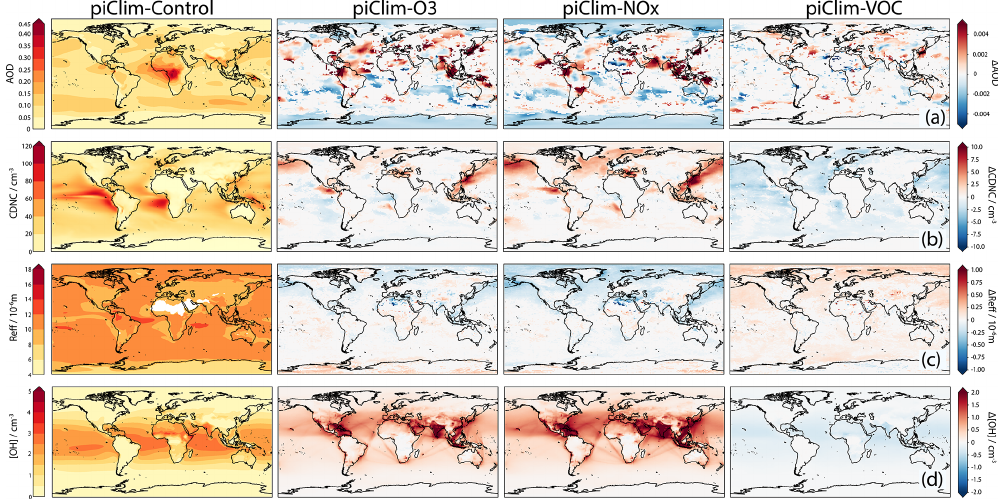
Figure 11. Global distributions of AOD at 550nm (row a ; left column), cloud droplet number concentration (CDNC; cm − 3 ) at 1km altitude (row b ; left column), cloud droplet effective radius (Reff; µm) at 1km altitude (row c ; left column), and OH number concentration (cm − 3 ) at 1km altitude (row d ; left column) in piClim-control . Differences with respect to piClim-control from piClim-O3 , piClim-NOx , and piClim- VOC can be seen in the second, third, and right-hand columns,